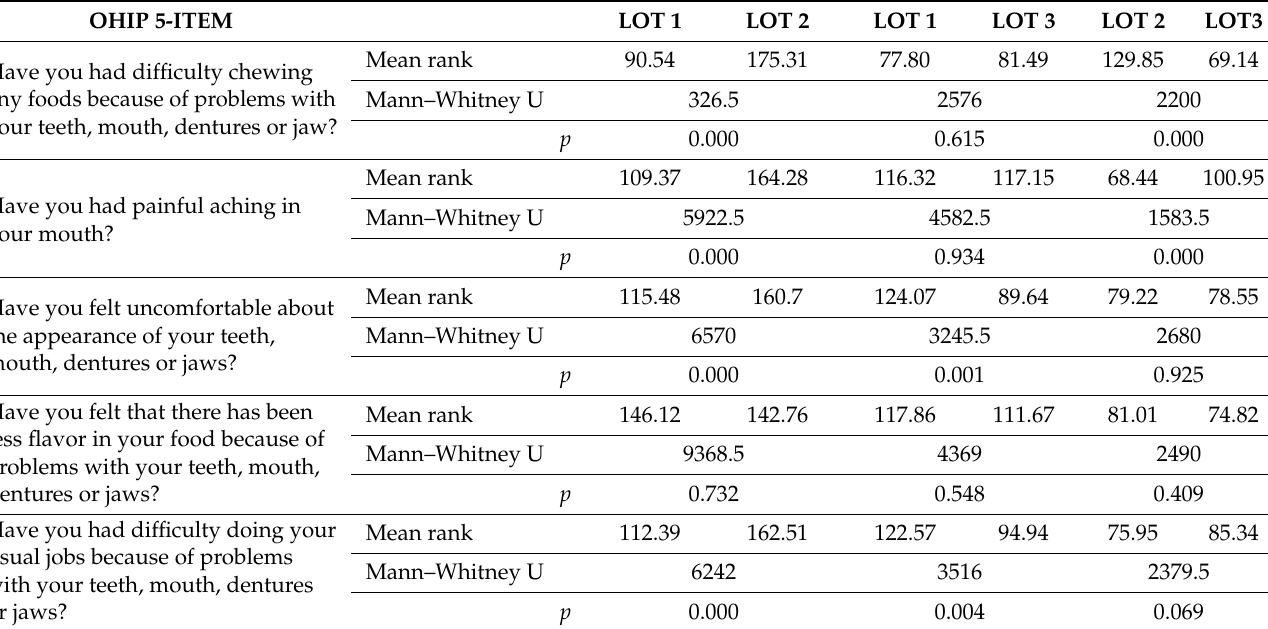
Table 2. Comparison of satisfaction between the three groups of RPD wearers.